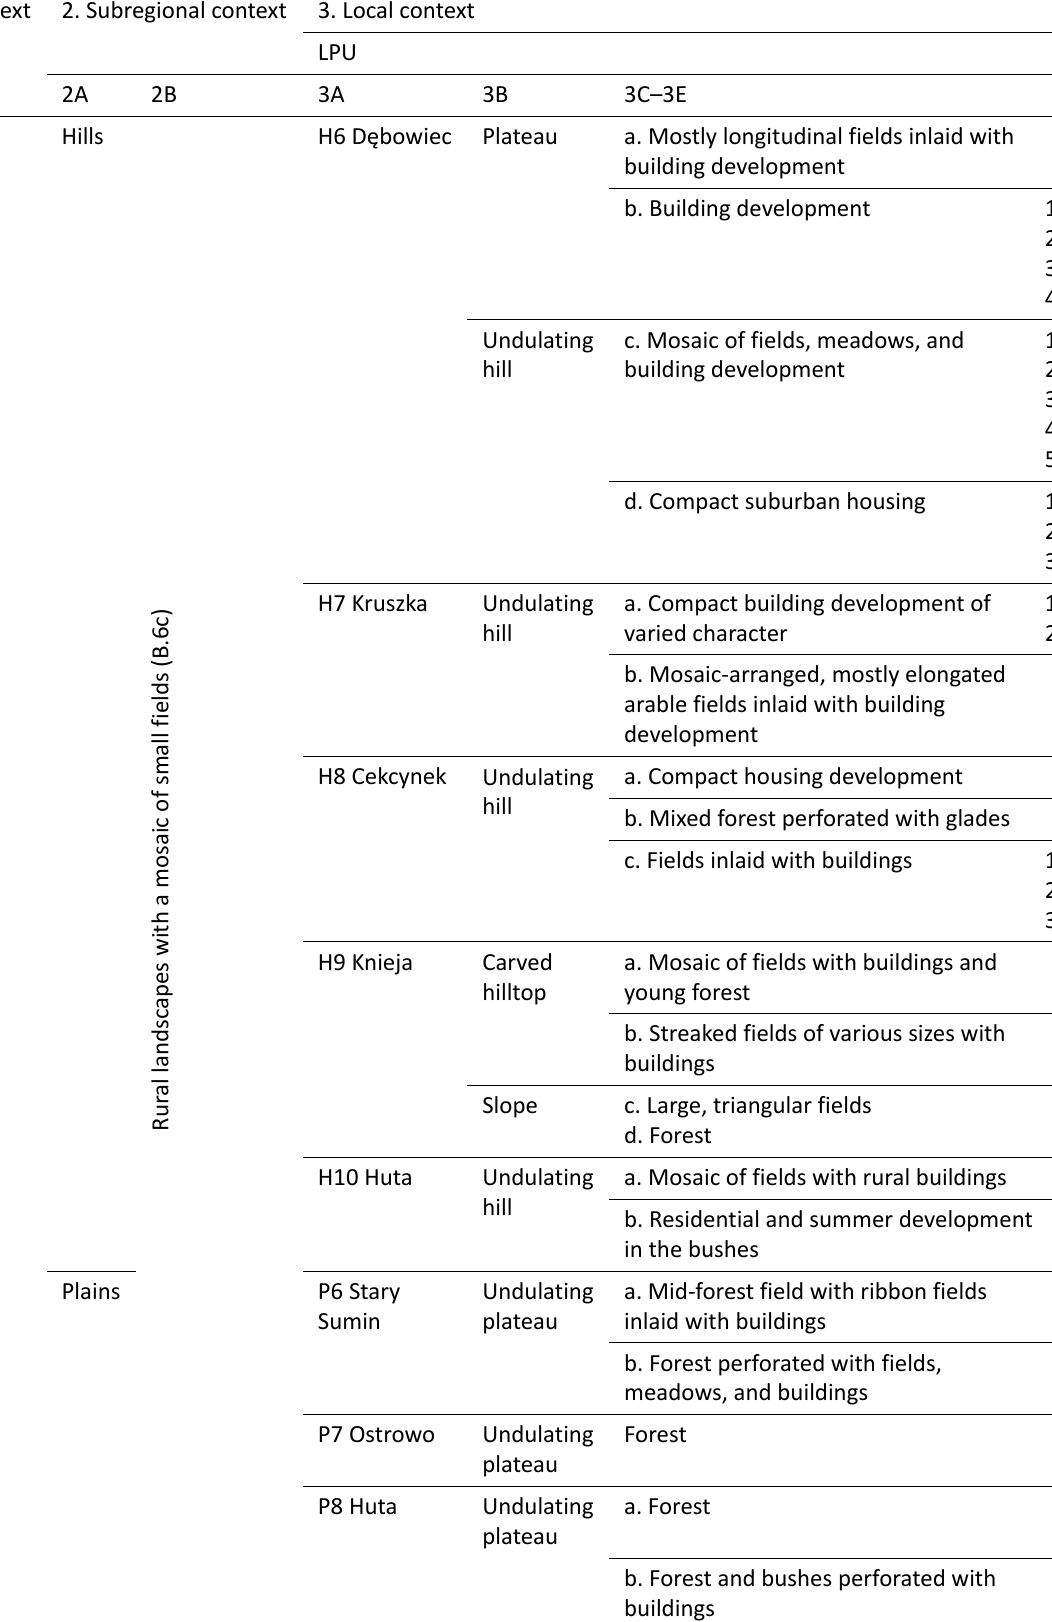
Table 2. (Cont.) Classification of the landscape units of the study area with integrated description of subunits. 1. Regional